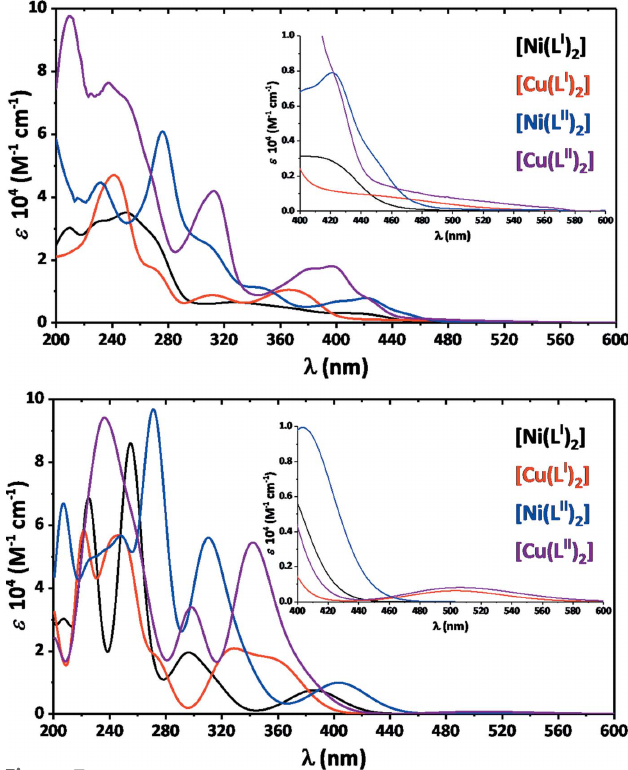
Figure 7 Experimental (top) and simulated (bottom) TDDFT (B3LYP/TZVPP/ PCM) UV–Vis absorption spectra of [Ni( L I,II ) 2 ] and [Cu( L I,II ) 2 ] in CH 2 Cl 2 .